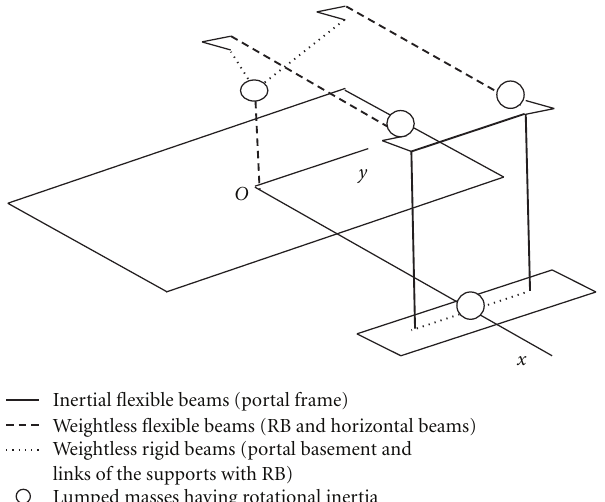
Figure 1: Scheme of the sample structure modeling the reactor building (RB) and transportation portal (TP). Basements’ contours are for the readability